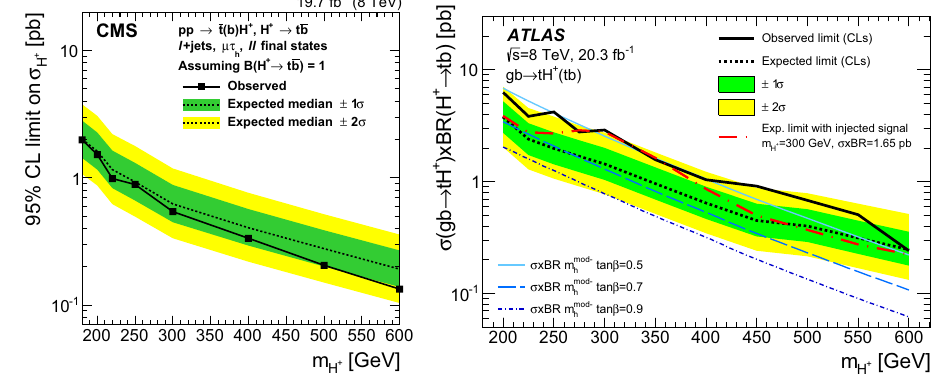
Fig. 23 Left CMS upper limits on σ( pp → t ( b ) H + ) for the combi- nation of the μτ h , (cid:12) + jets, and (cid:12)(cid:12) (cid:12) final states assuming BR ( H + → t ¯ b ) = 100%. (Reprinted with kind permission from JHEP and the authors, Fig. 10 of [216]). Right ATLAS upper limits for the produc-